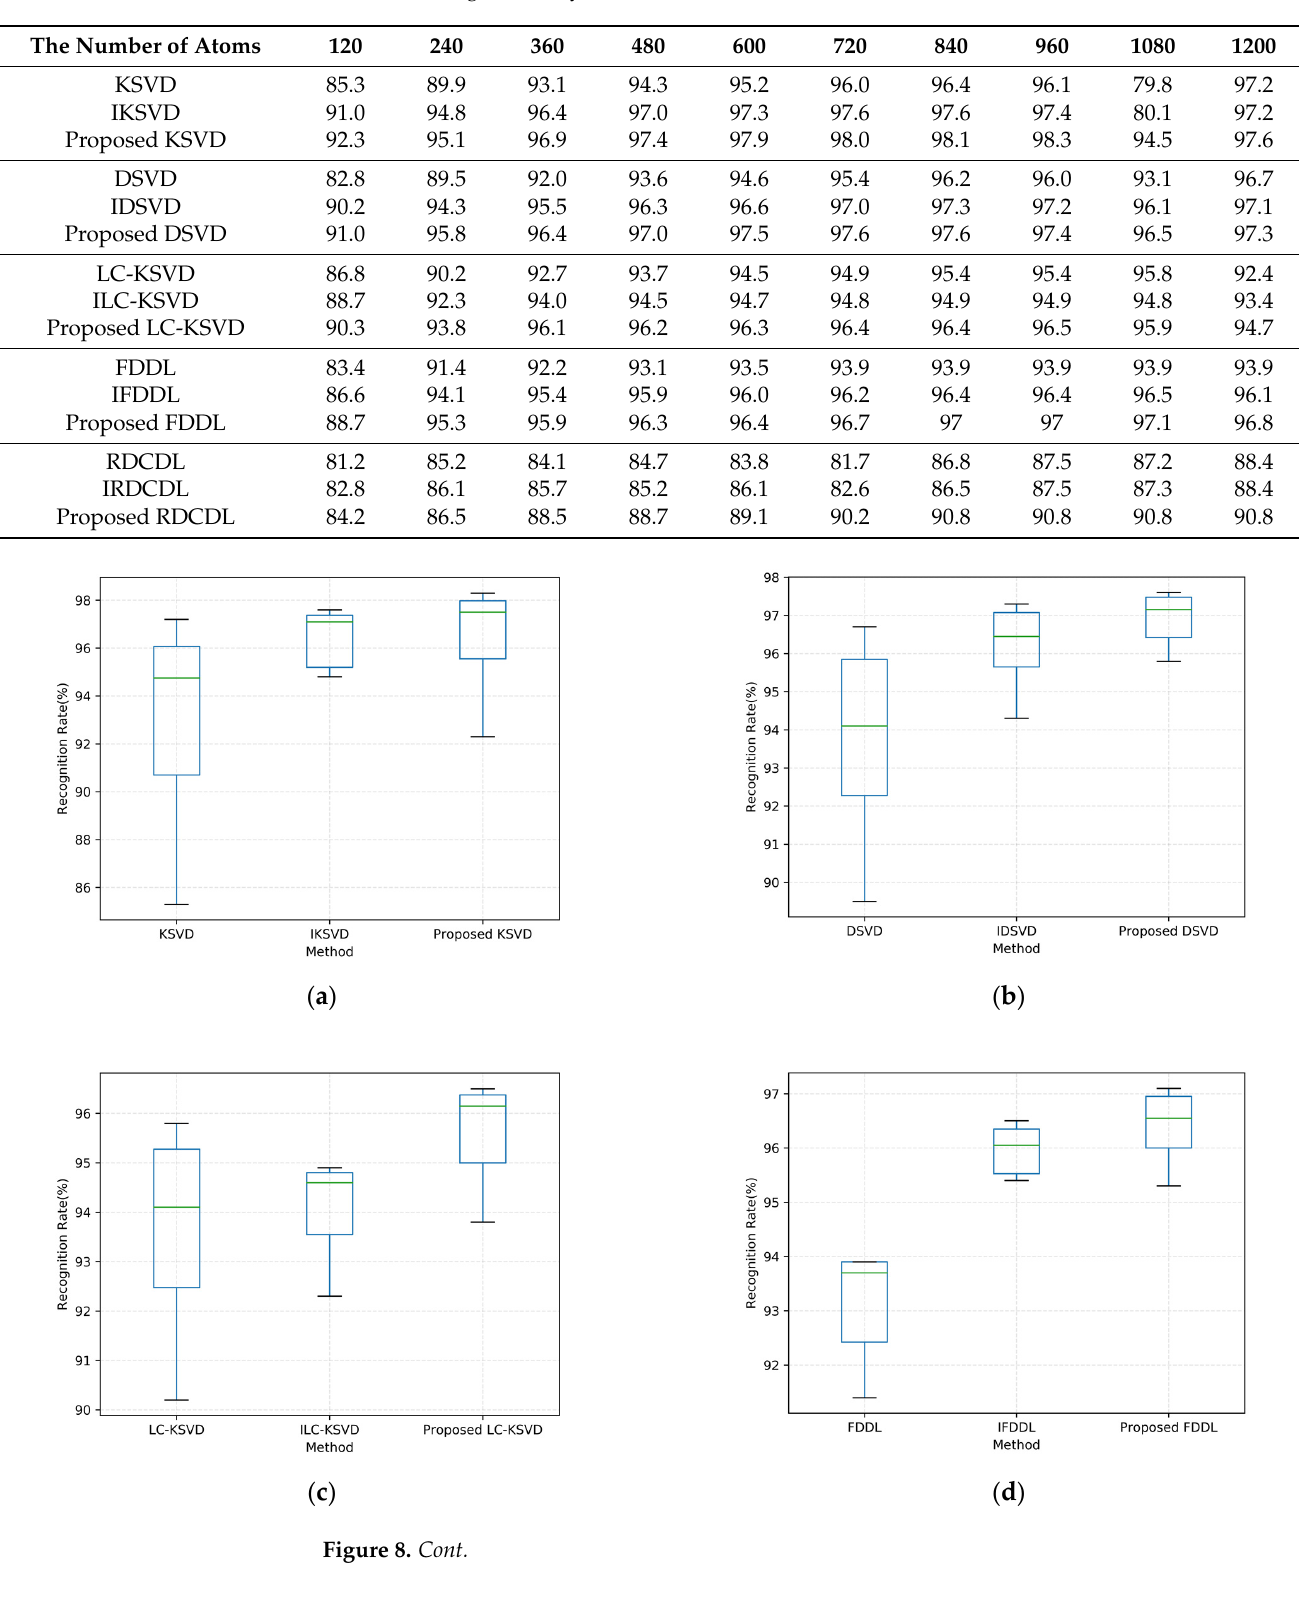
Table 3. Average accuracy (%) on the AR face